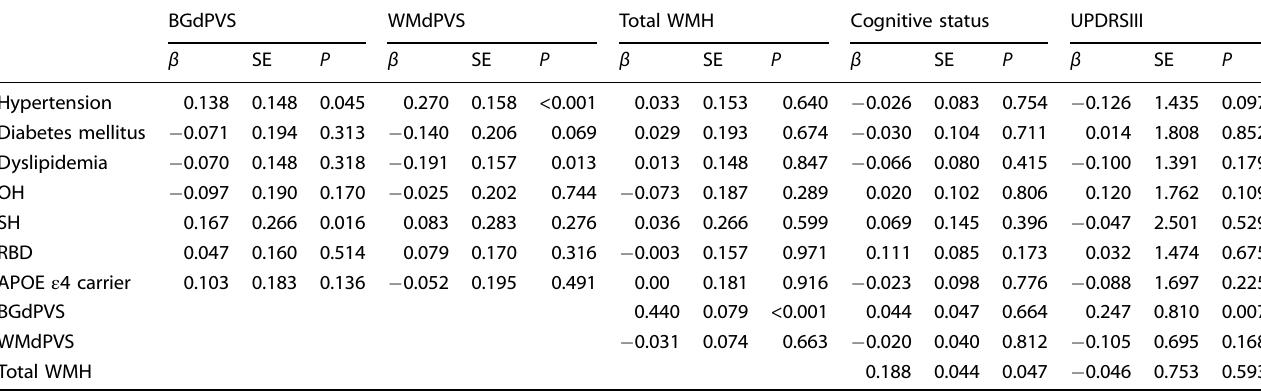
Table 2. Effects of predictors on cognitive status and motor symptoms through mediators when total WMH was used as a variable.